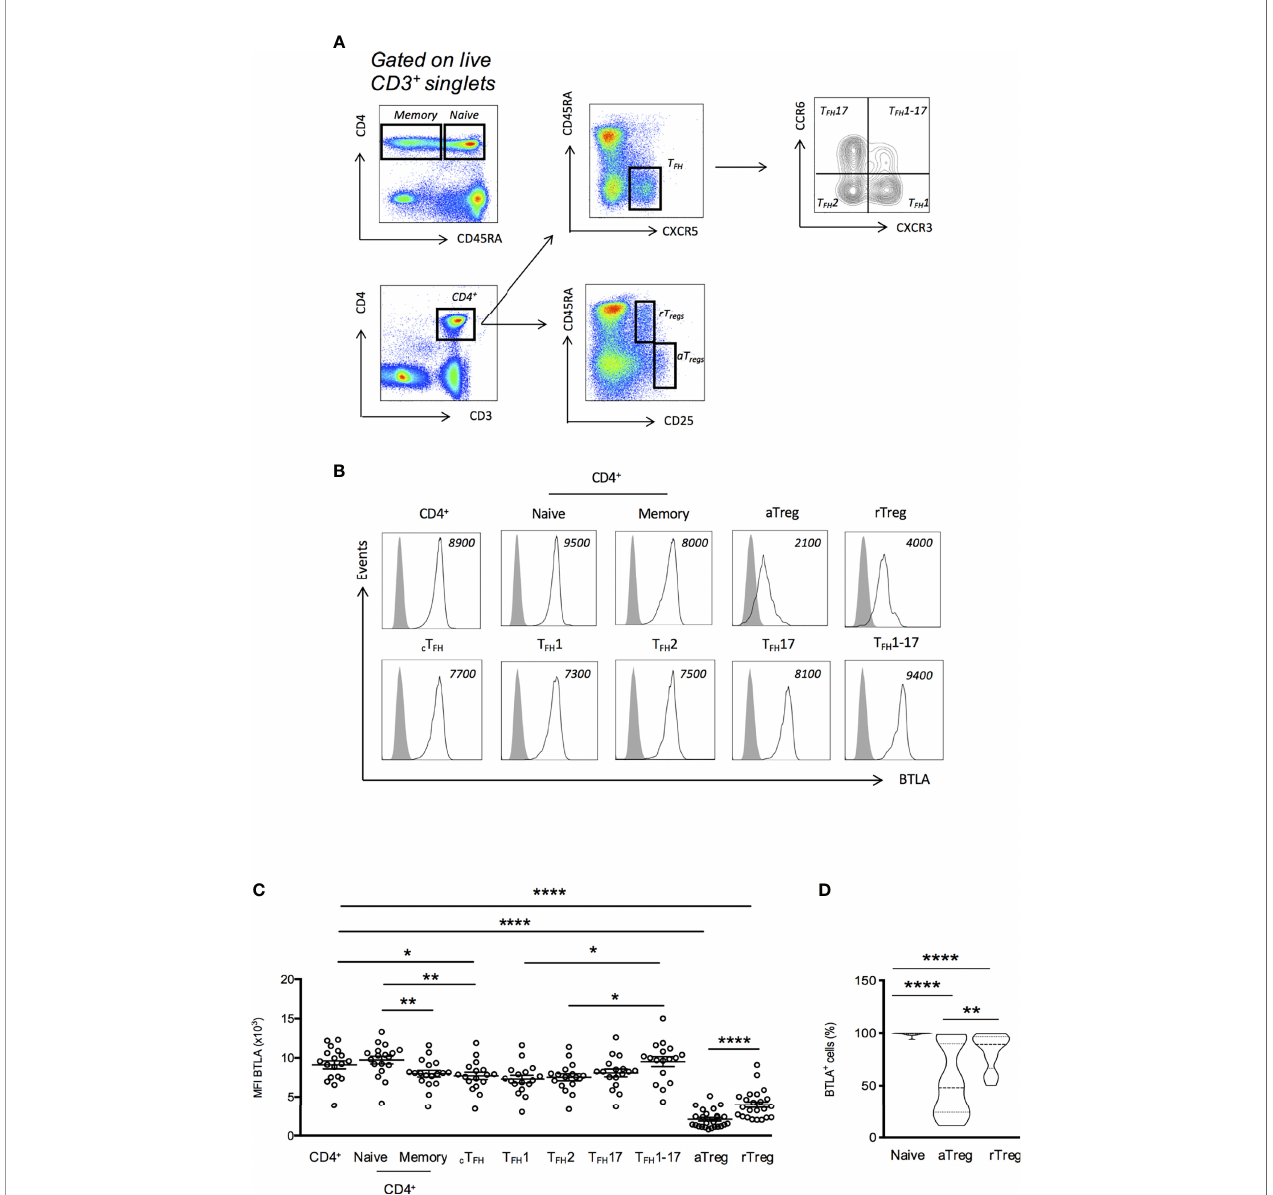
FIGURE 1 | BTLA expression on T cell subsets from HC. (A) Flow cytometry gating strategy of T cell subsets de fi ned by CD3, CD4, CD45RA, CXCR5, CCR6, CXCR3 and CD25. (B) Representative histograms of BTLA expression on T cell subsets. Data from a representative HC are shown as an example and MFI values are indicated. (C) BTLA expression (MFI) on T cell subsets in HC (n=17-34). (D) Frequency of BTLA expressing cells in naive CD4 + T cells, aTregs and rTregs in HC. Results are expressed as mean ± SEM and each dot represents one individual. Frequency values are displayed as mean (dashed lines) plus lower and upper quartiles (dotted lines). *p < 0.05; **p < 0.01; ****p < 0.0001,